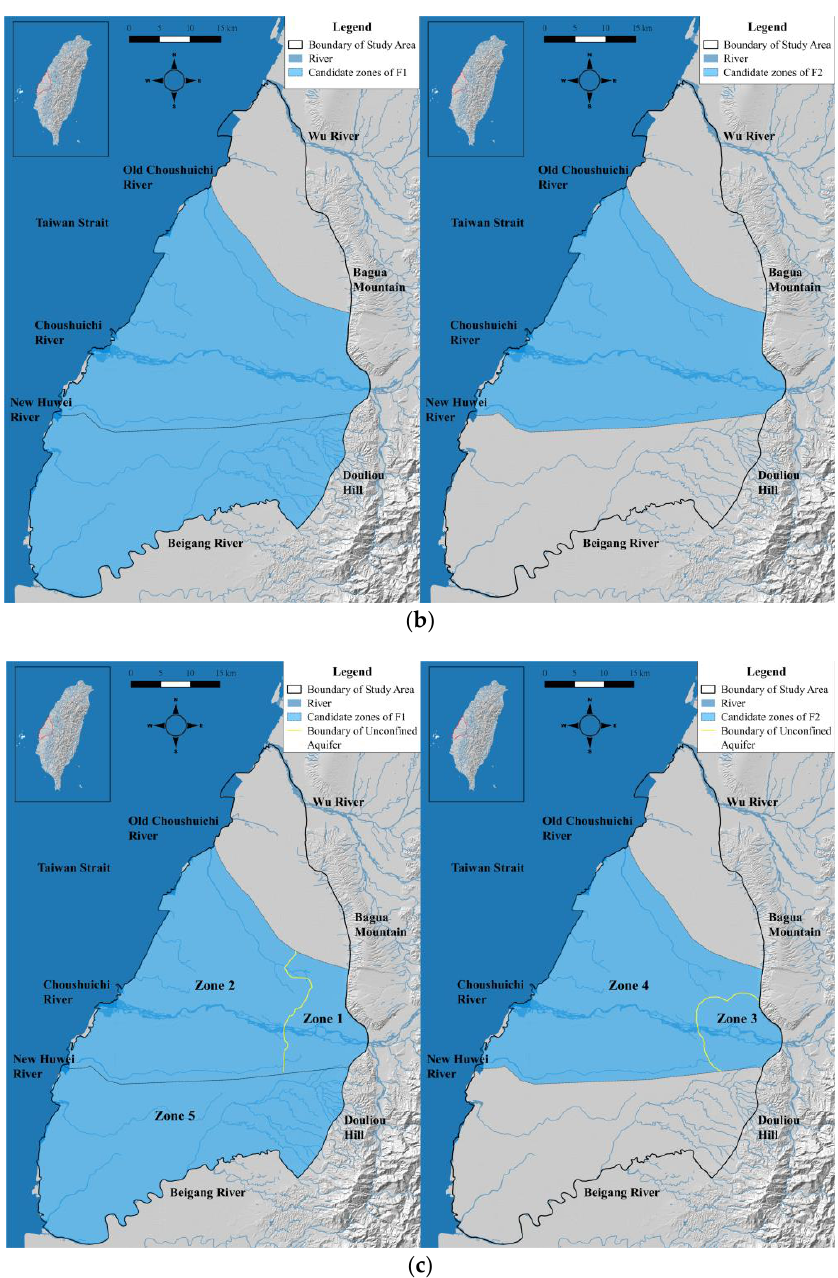
Figure 7. Zonation process for the study area. ( a ) The original stratigraphy; ( b ) the selected candidate zones after considering the area of fan delta; ( c ) the selected zones for data classification.